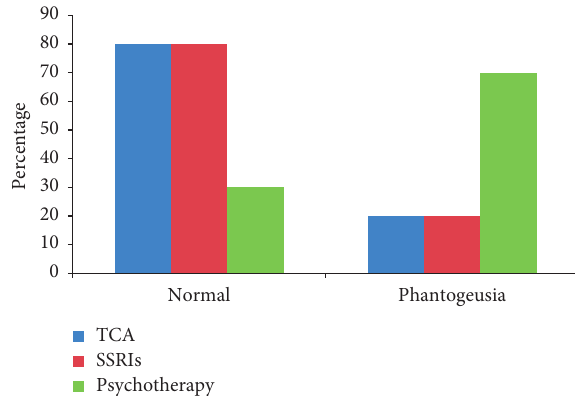
Figure 2: Bar chart representing normal taste and phantogeusia among the studied groups.